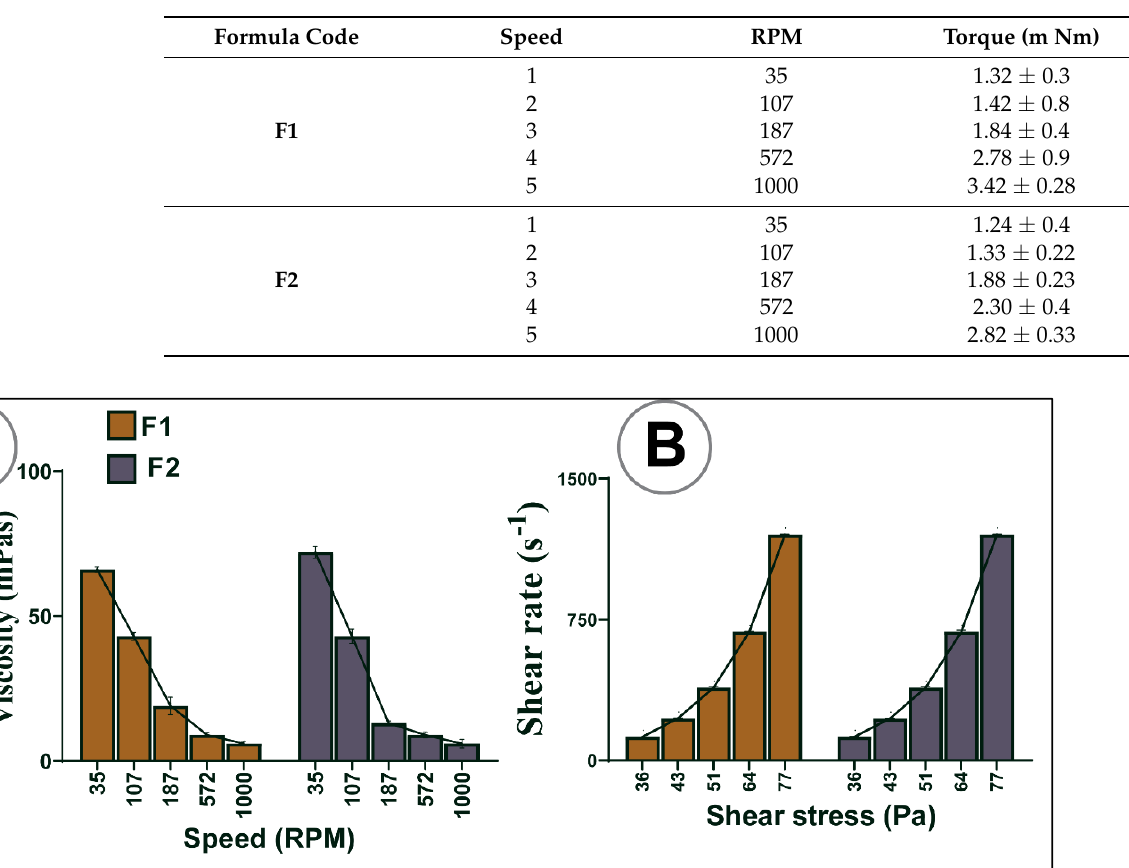
Figure 3. Rheological parameters ( A ) influence of speed on viscosity, ( B ) influence of shear stress on shear rate. N = 3, mean ± SD. Table 2. Rheological parameter measurement before microencapsulation at various mixing speeds: N = 3, mean ± SD.